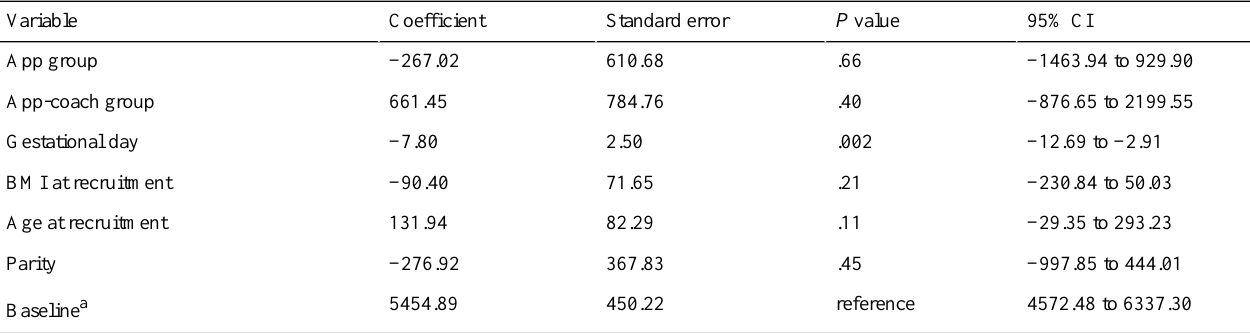
a Baseline represents baseline step count for an individual in the control group between 61 and 90 gestational days with a BMI of 35 kg/m 2 , 30 years of age, and with no previous